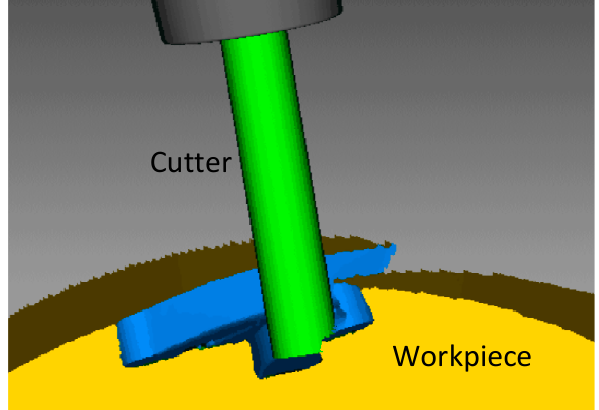
Figure 1. A flat end mill is fully engaged into the material of the workpiece in the rough milling of a blisk.